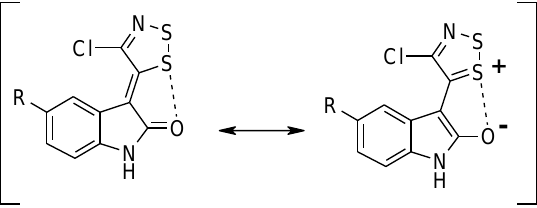
Figure 3. Representation of the O–S attractive interaction, and selected mesomer forms for the ( Z )-3-(1,2,3-dithiazol-5-ylidene)indololin-2-ones (Table 1, 3a ).